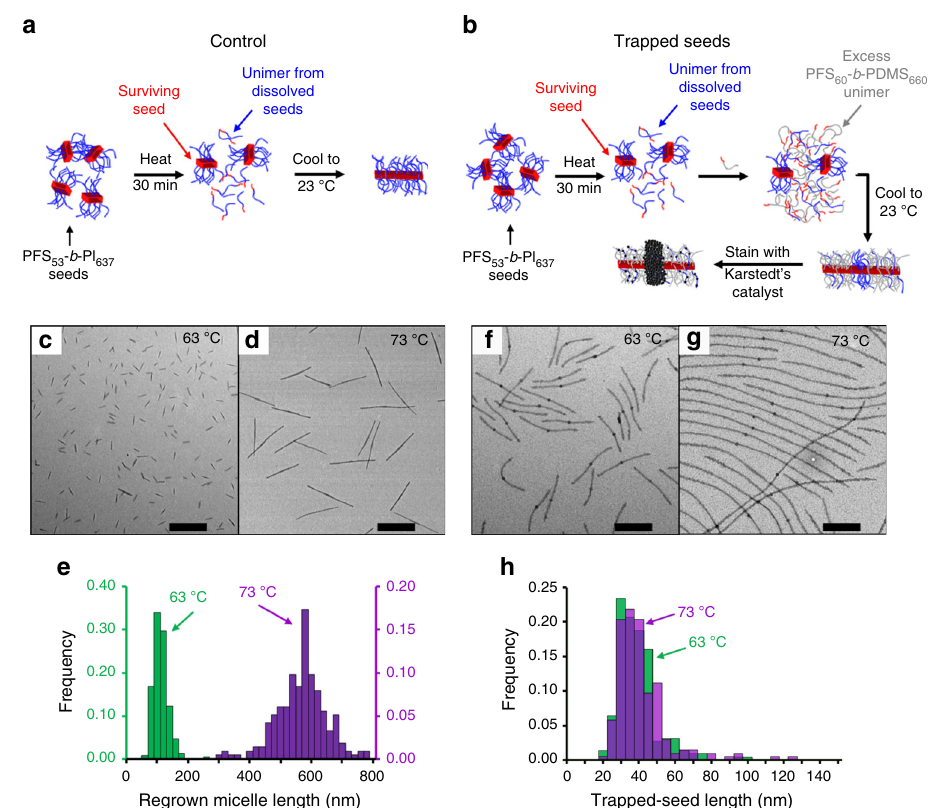
Fig. 1 Investigation of crystallite dissolution by seed trapping. Schematic diagram describing a the control and b the seed trapping experiments performed to study the dissolution of PFS 53 - b -PI 637 crystallites heated for 30 min in decane at different temperatures. In this scheme we use a color code to represent different chemical species: red represents polyferrocenyldimethylsilane (PFS) (either as the PFS block of a unimer or the crystalline core of a micelle), blue represents polyisoprene (PI), gray represents polydimethylsiloxane (PDMS), while the black spheres represent the platinum nanoparticles from Karstedt ’ s catalyst used to stain PI. c and d TEM micrographs of PFS 53 - b -PI 637 micelles obtained by heating PFS 53 - b -PI 637 seeds in decane for 30 minutes at c 63 °C, and d 73 °C, and cooling them to room temperature. e Length distribution histograms of the micelles shown in ( c ) (63 °C, green columns), and ( d ) (73 °C, purple columns). TEM micrographs of triblock comicelles obtained by heating PFS 53 - b -PI 637 seeds 25 minutes at f 63 °C and g 73 °C then adding PFS 60 - b - PDMS 660 unimer, and after fi ve more minutes, letting the solution cool to room temperature. h Length distribution histograms of the surviving PFS 53 - b - PI 637 seeds after the sample was annealed at 63 °C (green columns) and 73 °C (purple columns). Samples f and g were trapped with excess of PFS 60 - PDMS 660 unimer, and stained with Karstedt ’ s catalyst to highlight the PI rich regions. Scale bars, 500